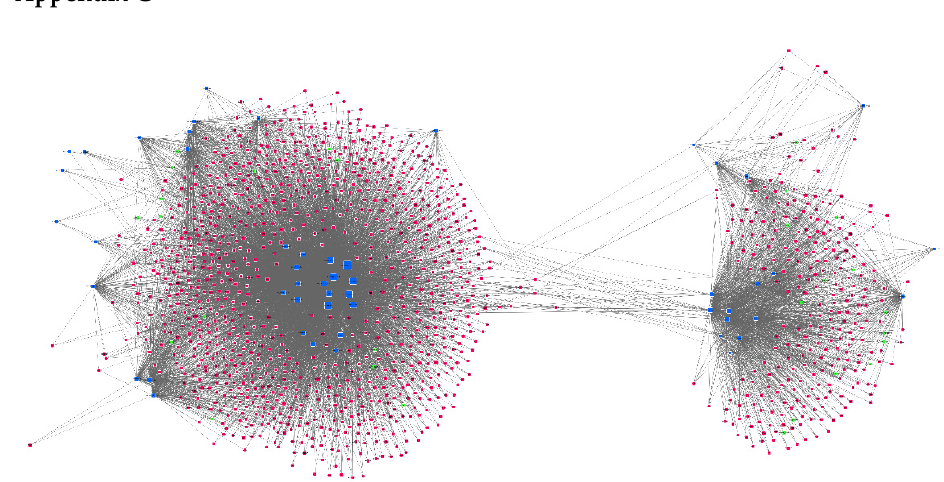
Figure A1. Network regulation of mRNA–circRNA–miRNA.